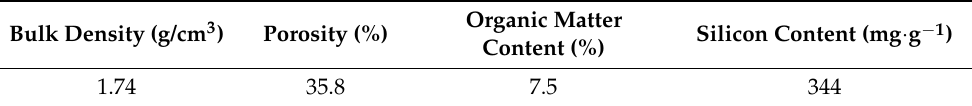
Table 1. Basic properties of the soil